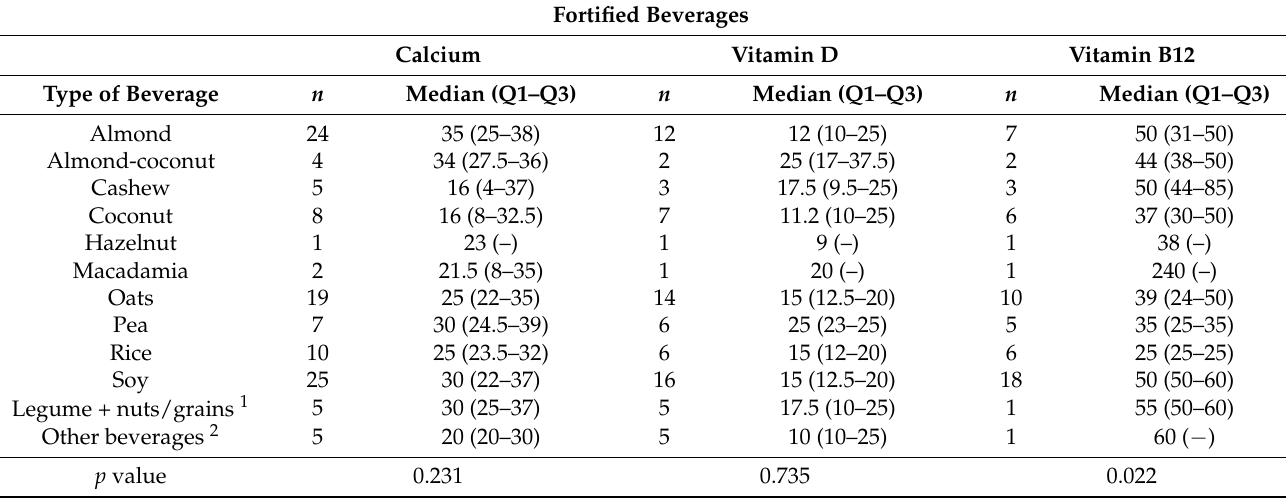
Table 7. Median (Q1–Q3) of calcium, vitamin D and vitamin B12 levels (%daily value) for only fortified beverages per serving, by type of